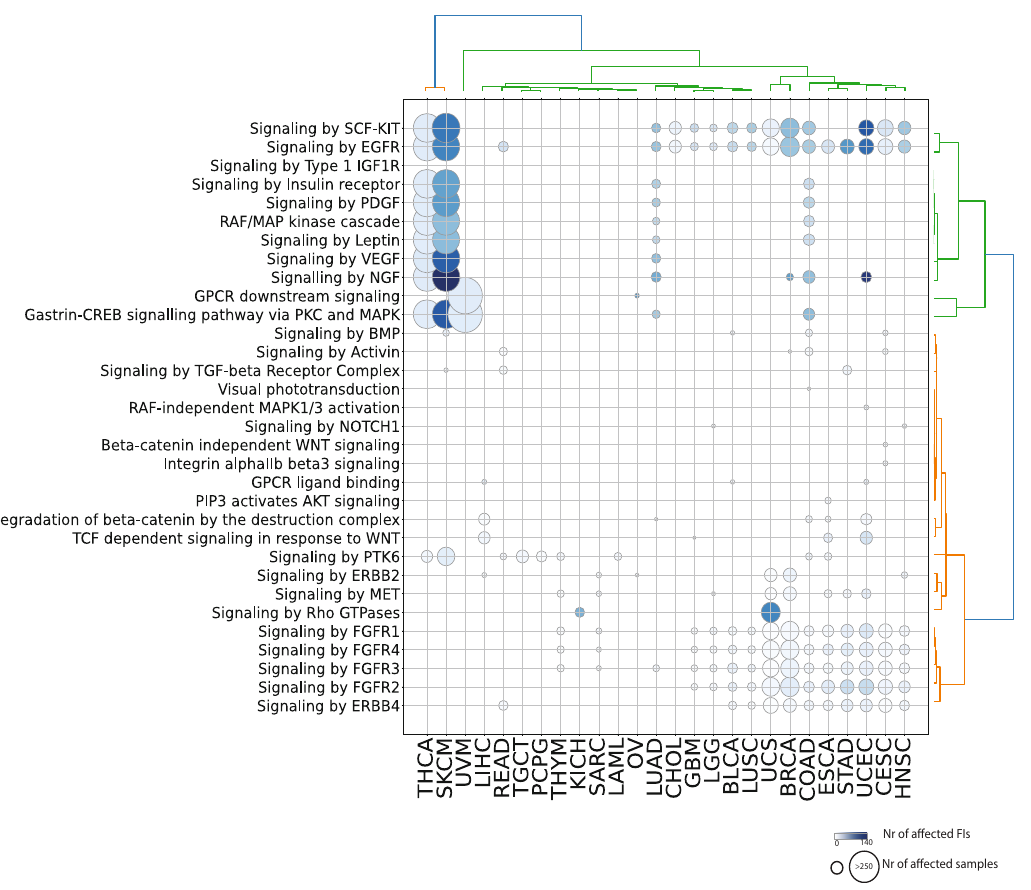
Figure 4. Significantly affected pathways belonging to the Signal Transduction domain. Diameters are pro- portional to the numbers of unique samples and color shades are proportional to the numbers of FI